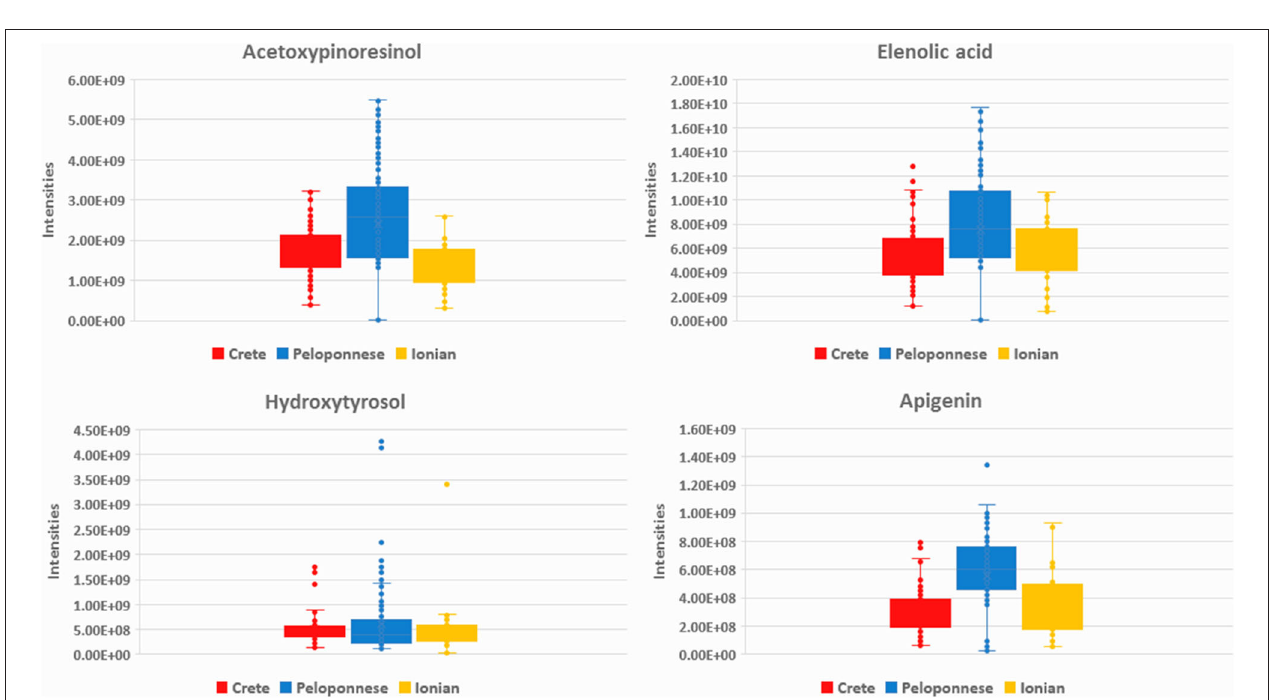
FIGURE 4 | Box-plots of acetoxypinoresinol ( 51 ), elenolic acid ( 13 ), hydroxytyrosol ( 6 ), and apigenin ( 20 ) in the three basic geographical regions Crete (red), Peloponnese (blue), and Ionian islands (yellow).